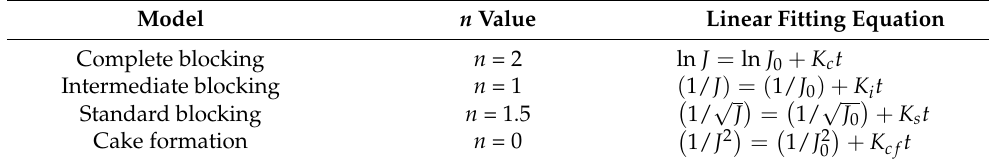
Table 3. Linear forms for different blocking mechanisms according to the Hermia